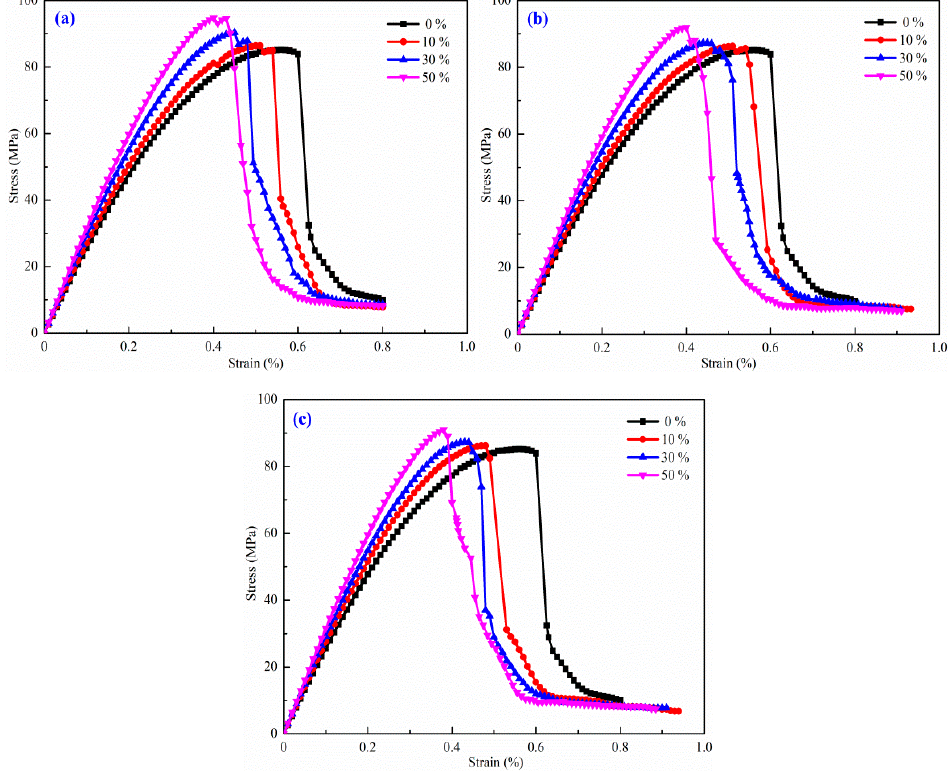
Figure 21. Stress–strain curves of glutenite specimen with various gravel sizes and gravel volume contents: gravel sizes are ( a ) 2.5 mm, ( b ) 3.75 mm, and ( c ) 5.0 mm. Table 6. Calculation results of brittleness indexes with various gravel sizes and volume